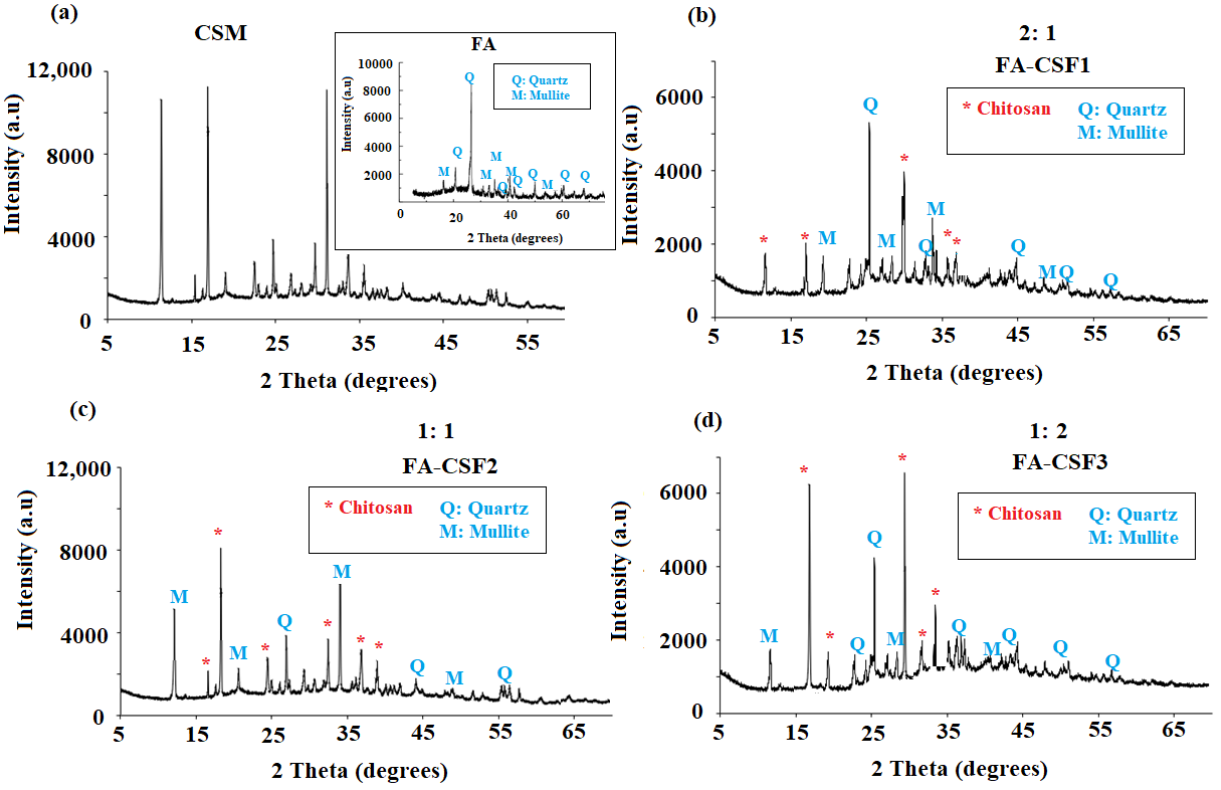
Figure 2. X-ray diffraction for ( a ) chitosan-based film (CSF) and ( b ) fly ash loaded chitosan-based CSF-FA1, ( c ) FA-CSF2, and ( d ) FA-CSF3 films.